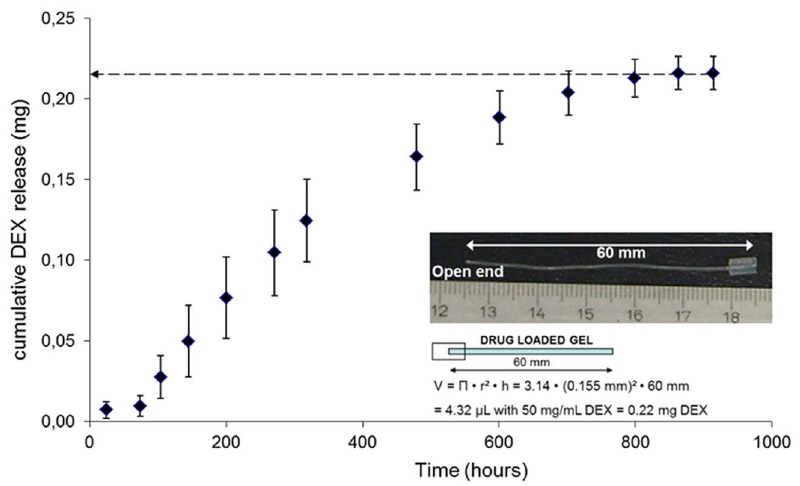
Figure 1. Image of a hydrogel reservoir with one end closed by a silicone septum for fluid injections (right end), while the other end is open in order to release the drug into the area to be addressed (left end) and calculation of the amount of drug inside the hydrogel filled tube. Drug release from this arrangement is shown in the diagram. The data points result from nine experiments from three different NCO-sP(EO- stat -PO) batches, each of them used for the preparation of three release setups.